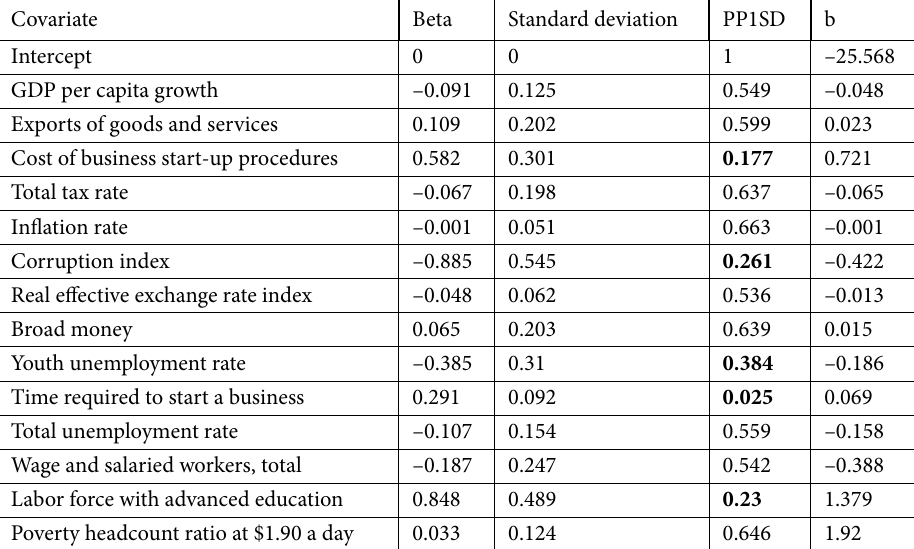
Table 5. Marginal posterior summary estimates for generalized ridge regression in case of Czech Re- public (source: own results) Covariate Beta